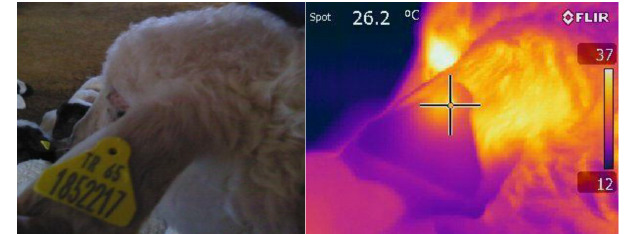
Figure 3. Infrared images of ear tissue after the application of metal-tipped ear tags in lambs (day 1).